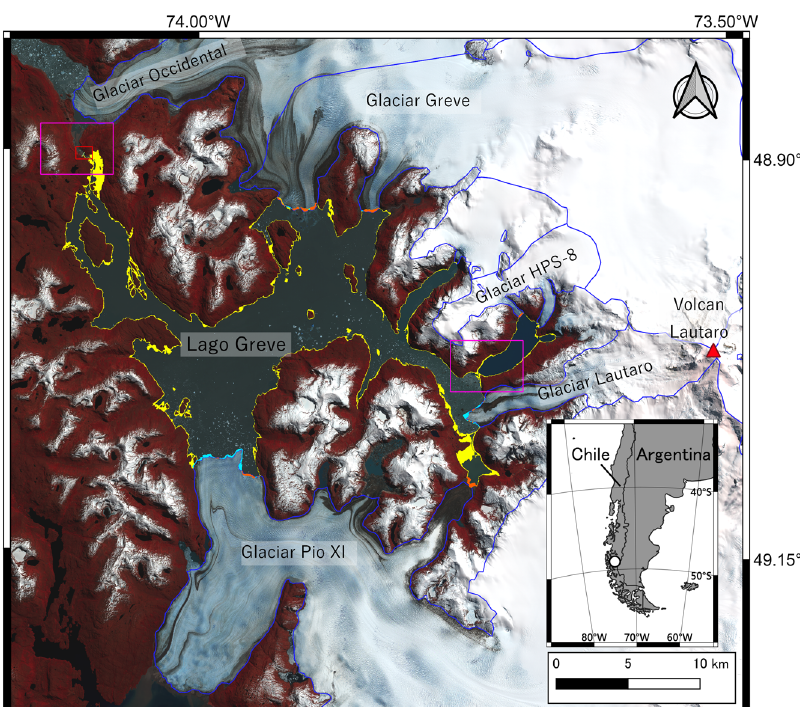
Fig. 1 Study site. Satellite image of Lago Greve (Sentinel-2 MSI image on 1st November 2020). The inset shows the location of the study site in South America. The area which turned from lake to land surface from 8 April to 1st November 2020 are highlighted in yellow. Areas highlighted in orange and cyan indicate advance and retreat of glacier calving fronts during the same period. Blue curves indicate glacier boundaries from RGI 6.0 inventory 69 (based on satellite imagery in 2000 – 2003), with glacier frontal margins delineated in this study. The red box in the upper left corner indicates the location of the lake outlet and the area shown in Fig. 4. The magenta boxes indicate the areas shown in Fig. 3.